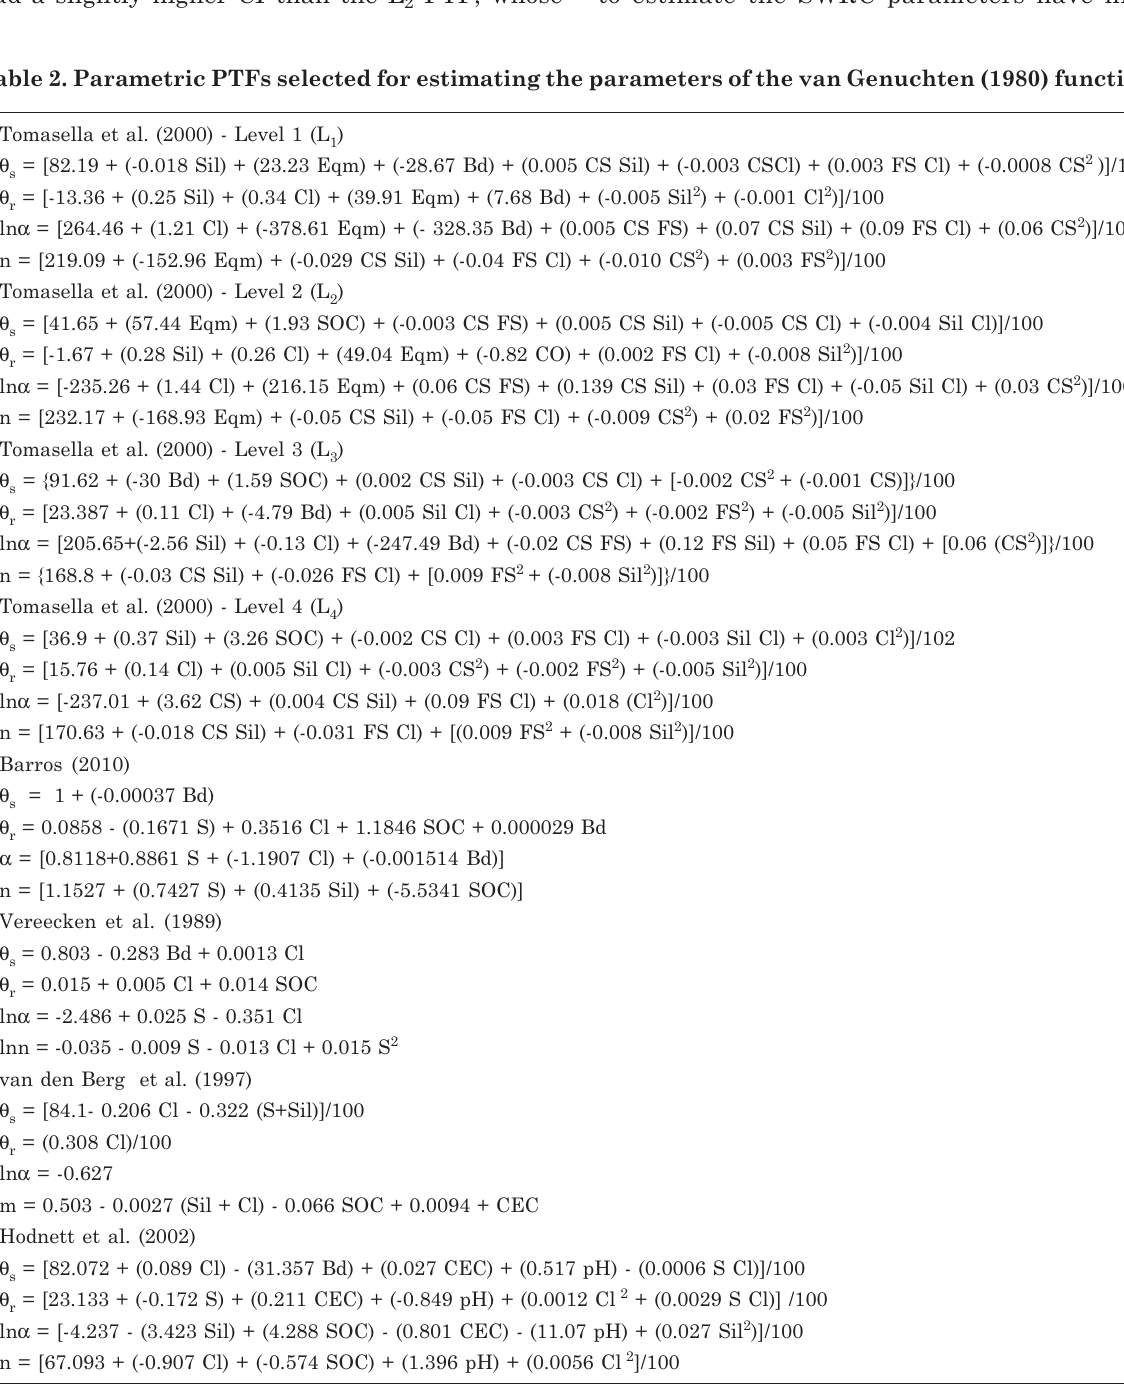
Table 2. Parametric PTFs selected for estimating the parameters of the van Genuchten (1980)